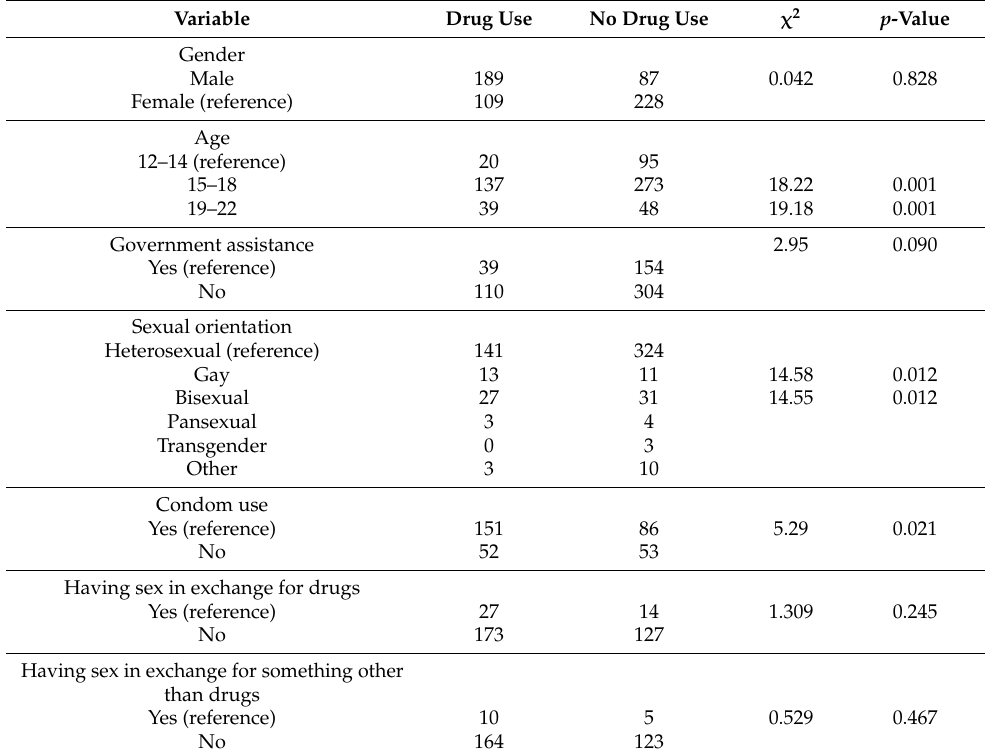
Table 2. Comparison of Chi-square test between drug use and sociocultural variables ( N =